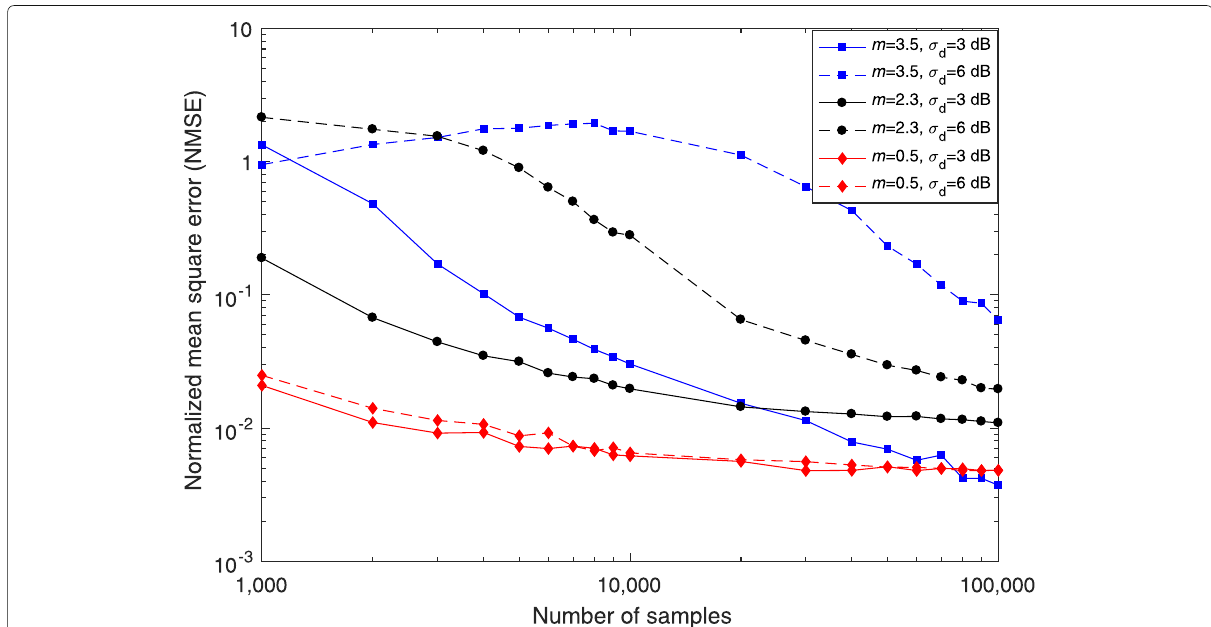
Fig. 5 Normalized mean square error of the ˆ m estimator of the fading parameter for the Nakagami- m process, as a function of the number of samples, N , for m = 0.5, 2.3, and 3.5 and standard deviations of the Gaussian process, σ d = 3 dB and σ d = 6 dB with ˆ m , independently of the standard deviation of the Also, the NMSE of the ˆ m increases substantially with the shadowing, σ d . fading parameter m for a sufficient number of samples. Nevertheless, the slope of the NMSE of ˆ m as a function In Fig. 6, the NMSE of the standard deviation estima- of the number of samples in logarithmic units tends to tor, ˆ σ d , is plotted as a function of the standard deviation stabilize for a number of samples given which increases in dB, σ d , for N = 10, 000 samples and M = 30, 000 trials.